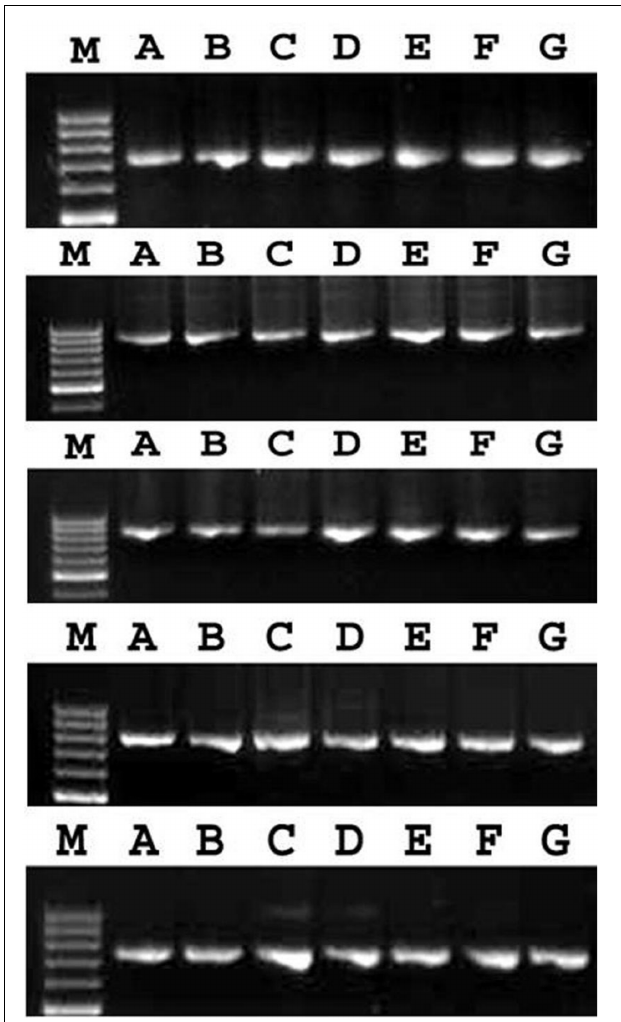
FIGURE 2 | PCR amplification of different fragments of NBS-LRR region of Pi9 gene from positive control, IRBL9-w (A) and six rice landraces (B–G). M, Molecular marker (1 kb) and lane A to G, PCR fragment obtained from overlapping fragments of Pi9 allele. Pi9 _1 primer (740 bp),